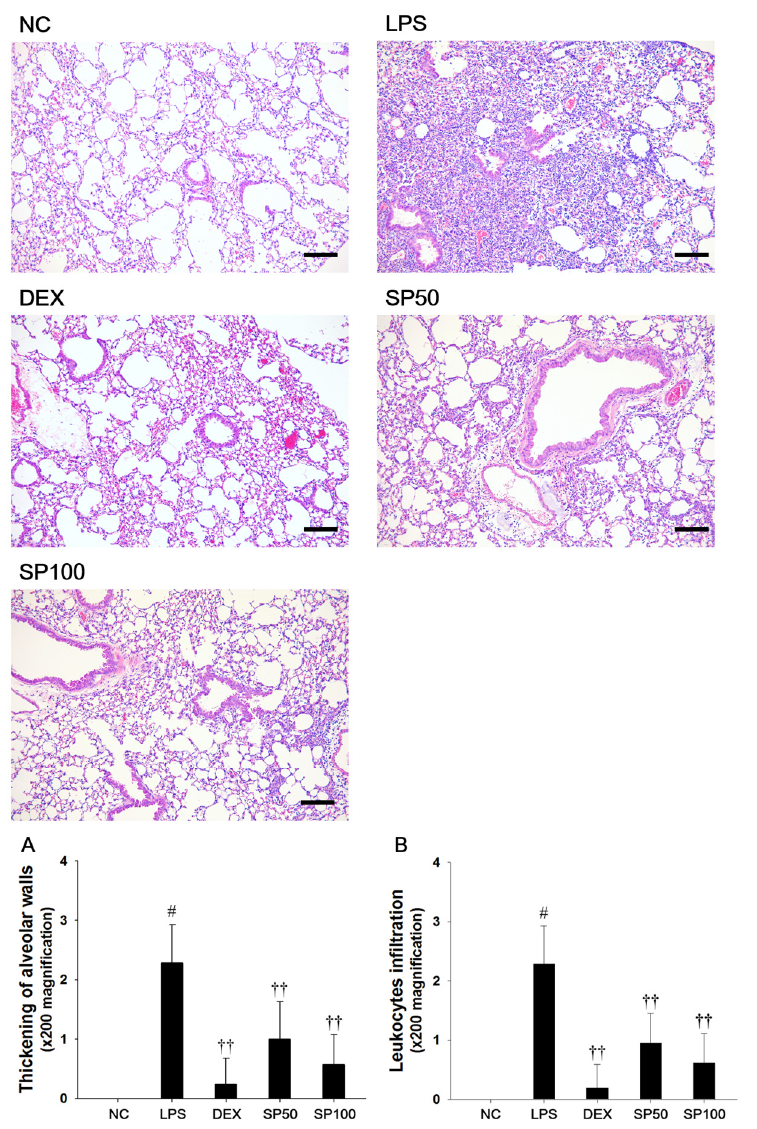
Figure 3. Effects of Spiraea prunifolia var. simpliciflora (SP) on airway inflammation in LPS-induced ALI mice. Histological examination of airway inflammation performed in the lung tissue by H&E staining. NC: normal control mice; LPS: LPS-induced mice; DEX: dexamethasone (3 mg/kg) + LPS-induced mice; SP 50: (50 mg/kg) + LPS-induced mice and SP 100: (100 mg/kg) + LPS-induced mice. Average pathologic scores of ( A ) thickening of alveolar walls and ( B ) leukocytes infiltration are expressed as the means ± SD ( n = 7/group). # Significantly different from NC group, p < 0.05; †, †† significantly different from LPS-treated group, p < 0.05 and p < 0.01.